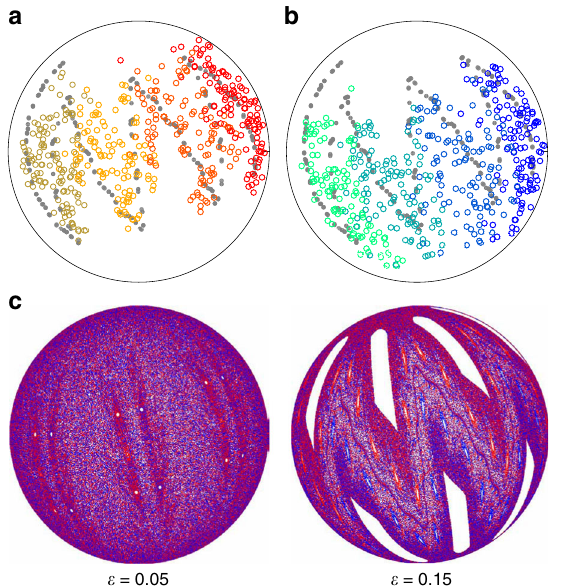
Fig. 8 Weak elliptic non-mixing barrier around period-4 regions under the (45°, 15°) protocol. a , b The tracer particle in 500-iteration experiments only occasionally crosses the mixing barrier (gray points). Color map illustrates the period-4 cycle. c Non-mixing regions are not evident for ϵ = 0.05 but become prominent with increasing fl owing layer depth in the FL model Fig. 9 Movement of persistent non-mixing regions through the fl owing